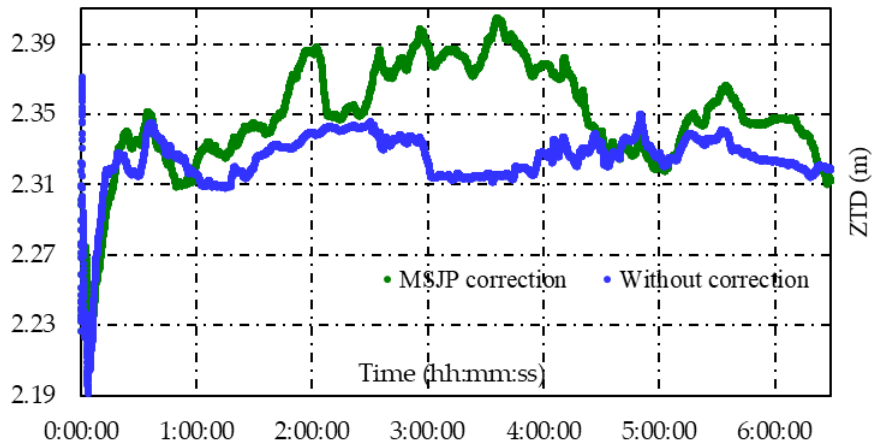
Figure 18. ZTDs from kinematic PPP with and without MSJP corrections.